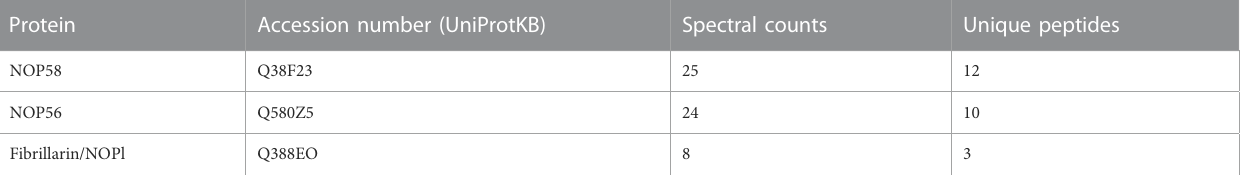
TABLE 2 Core C/D snoRNPs identi fi ed in Tb TERT complex.